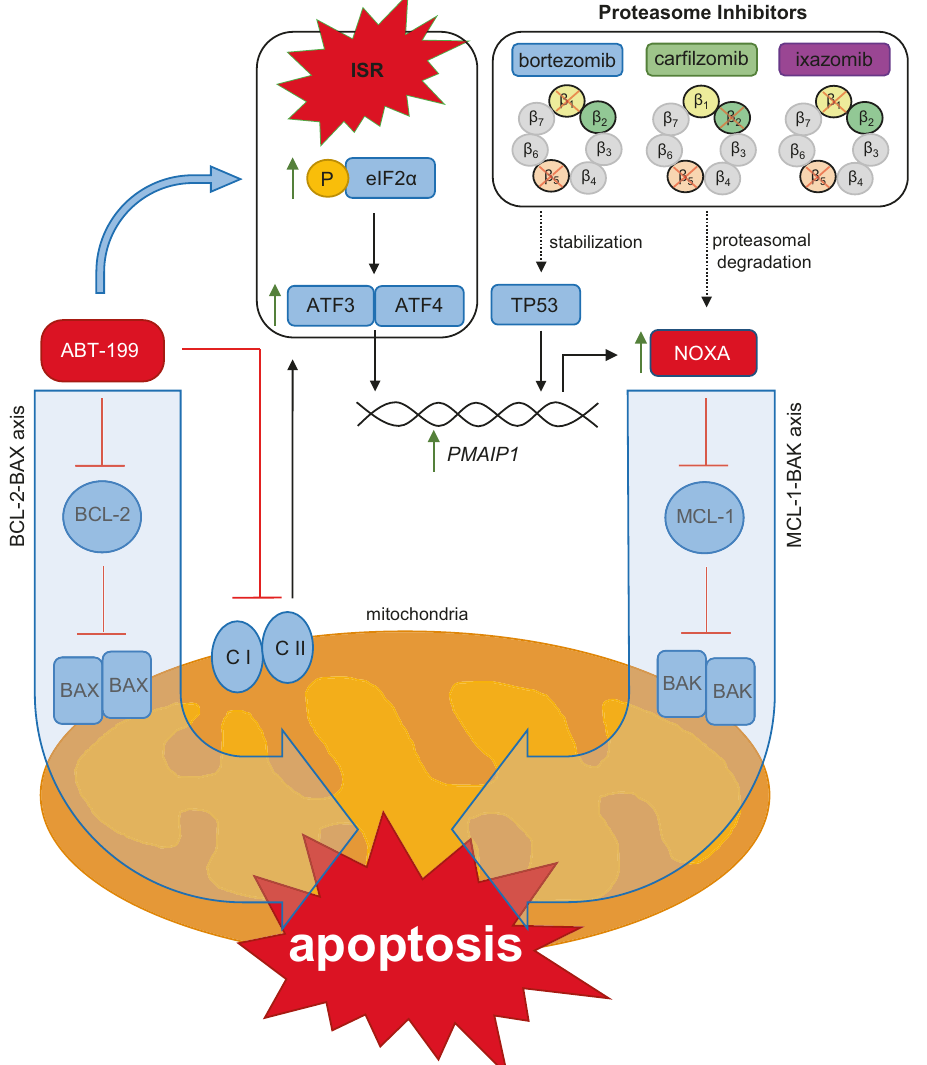
Fig. 6 The proposed mechanism underlying synergistic cell death induction by ABT-199&PIs by transactivation of NOXA. Besides stabilization of TP53, proteasome inhibition by BTZ, CFZ, or IXZ prevents proteasomal degradation of the BH3-only protein NOXA. (I) The BH3- mimetic ABT-199 antagonizes the anti-apoptotic activity of BCL-2 thereby releaving BAX. (II) ABT-199 reduces activity of complexes I and II of the mitochondrial ETC mediating metabolic reprogramming that induces ISR manifesting in (P)-eIF2 α and increased expression of ATF4 and ATF3. ATF3&ATF4 mediate transactivation of PMAIP1 /NOXA that inhibits the anti-apoptotic activity of MCL-1. Thus, unrestrained effectors BAX and BAK are free to oligomerize and mediate mitochondrial outer membrane permeabilization (MOMP) that sets the intrinsic apoptosis machinery in